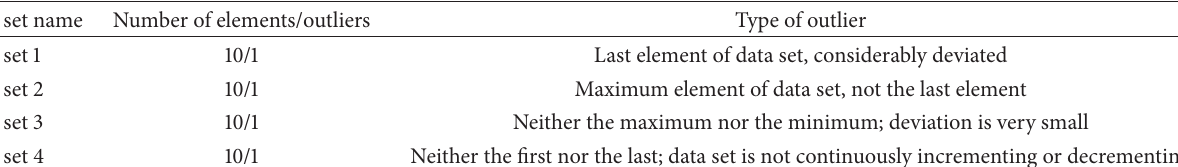
Table 2: Type of outlier contained in the data sets.